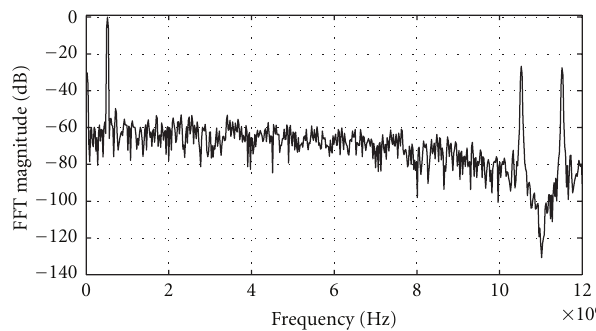
Figure 18: Output signal frequency spectrum.